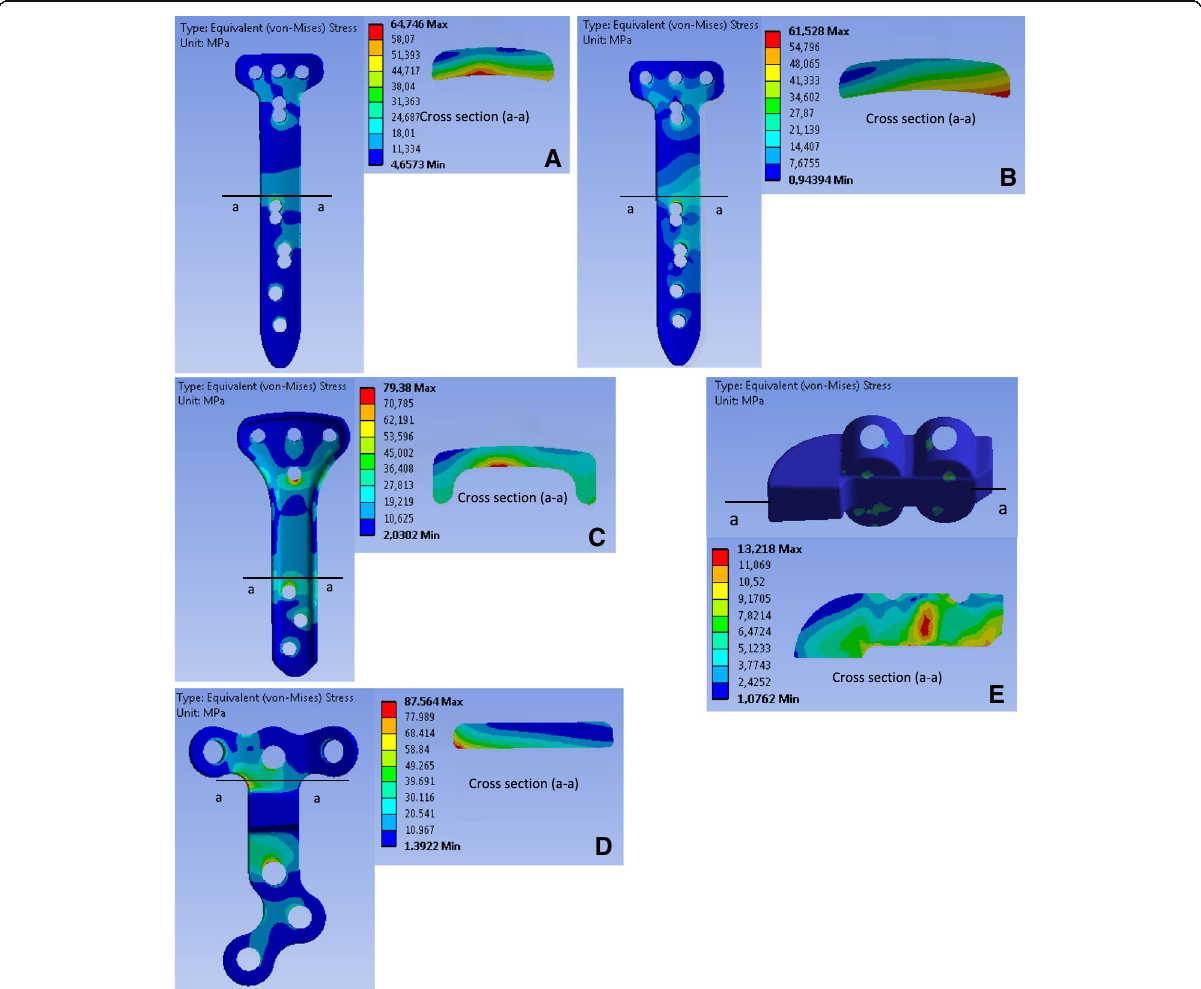
Fig. 8 Equivalent stress (von-Mises) in the implants in position 3: The letters a, b, c, d and e indicate the TomoFix sm, the TomoFix std., the PEEK Power, the Contour Lock and the iBalance implants